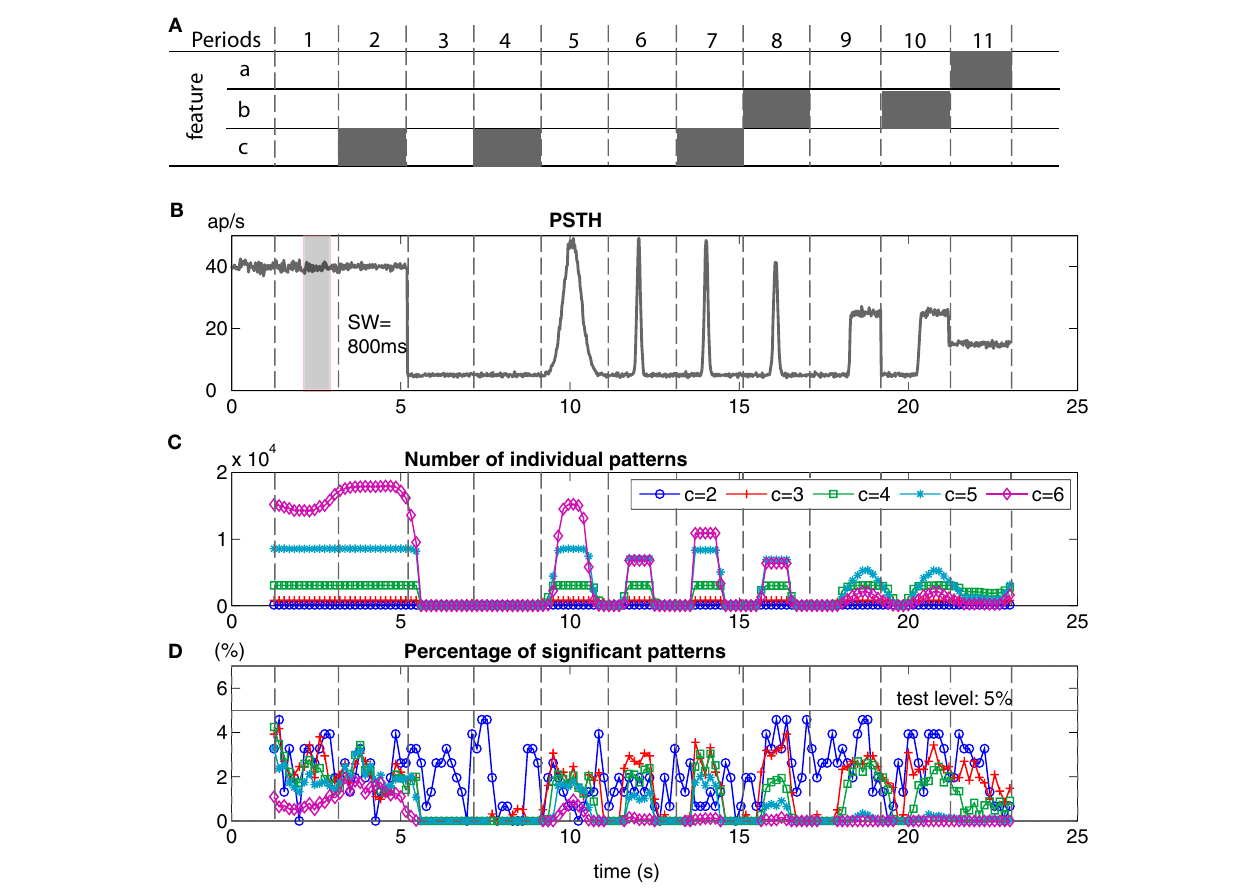
of the neurons, varies by a random amount between 0 and 100 ms. Feature c (periods 2, 4, 7) represents inhomogeneous gamma processes, with shape factor g = 7, instead of Poisson processes. (B) The peristimulus time histogram (PSTH) displays the rate profile of the non-stationary processes. During period 5, the spike rate is modulated from 5 to 50 spikes/s with a Gaussian shape with s = 250 ms, and during periods 6, 7, and 8, s = 50 ms. The spike rates in periods 9 and 10 were t modulated from 5 to 30 spikes/s by a step function. (C) The number of individual JS-patterns of complexities 2–6 that were detected in each sliding window ( t = 5 ms, “SW” = sliding window = 800 ms). (D) The percentage of JS-patterns c that show significantly different occurrence frequencies between the two conditions (test